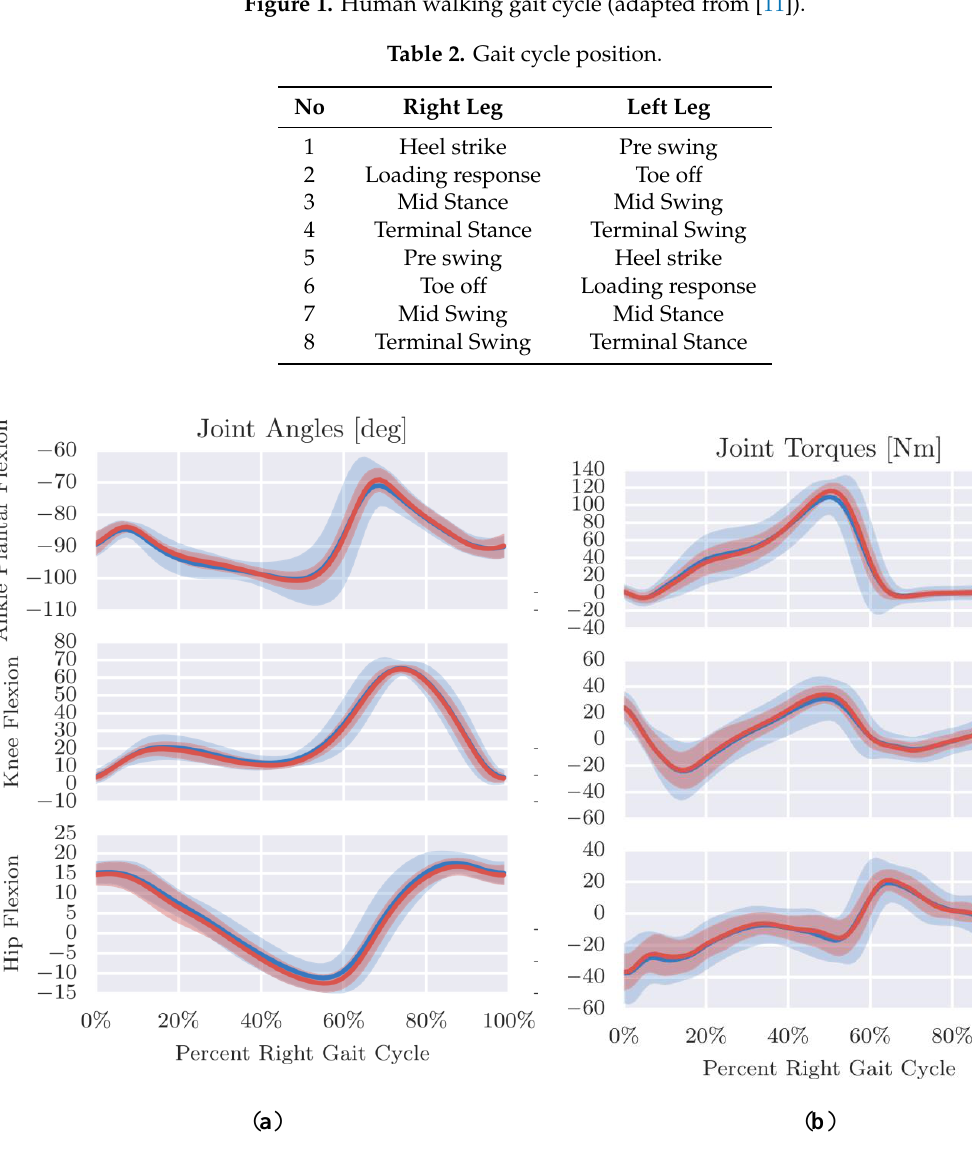
Figure 2. ( a ) Angles of joints and ( b ) torques of the joint versus the gait cycle (adapted from [12]).